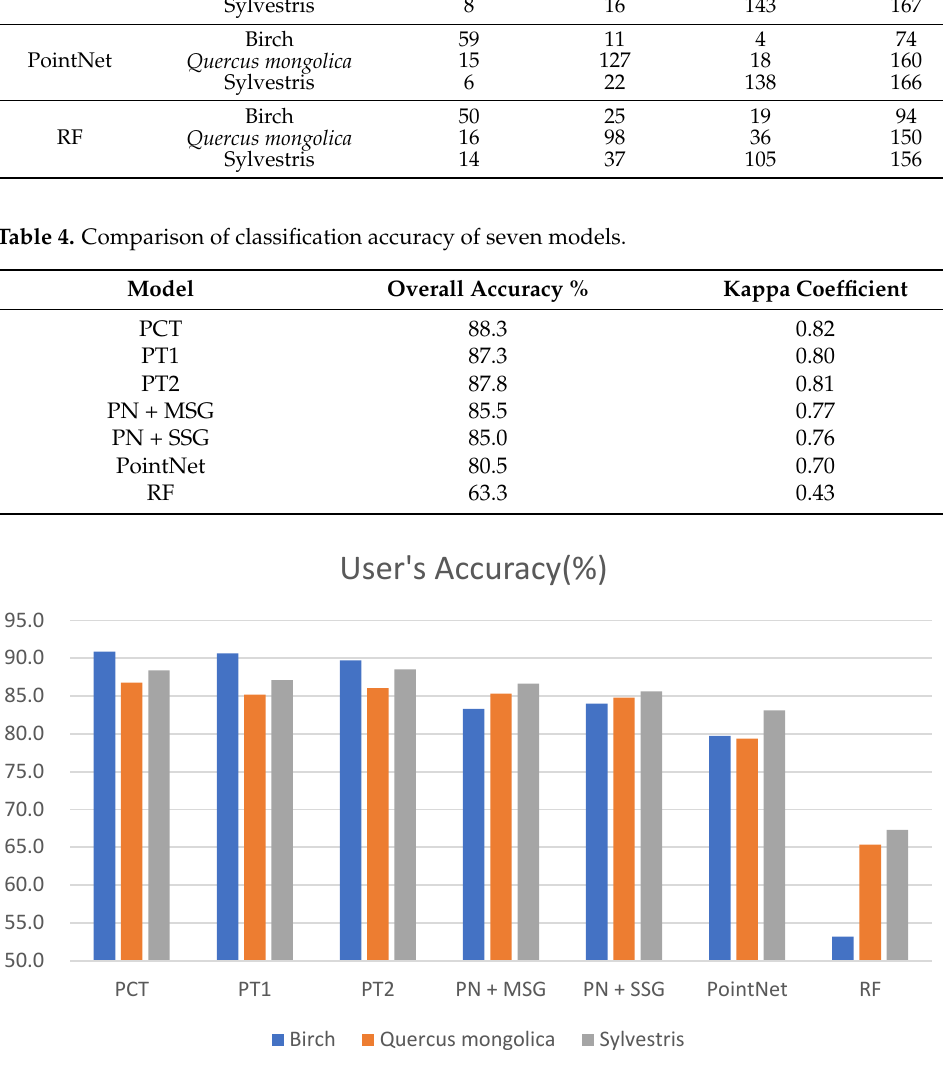
Figure 12. UA (user’s accuracy) bar chart of seven algorithm calculated from confusion matrix.